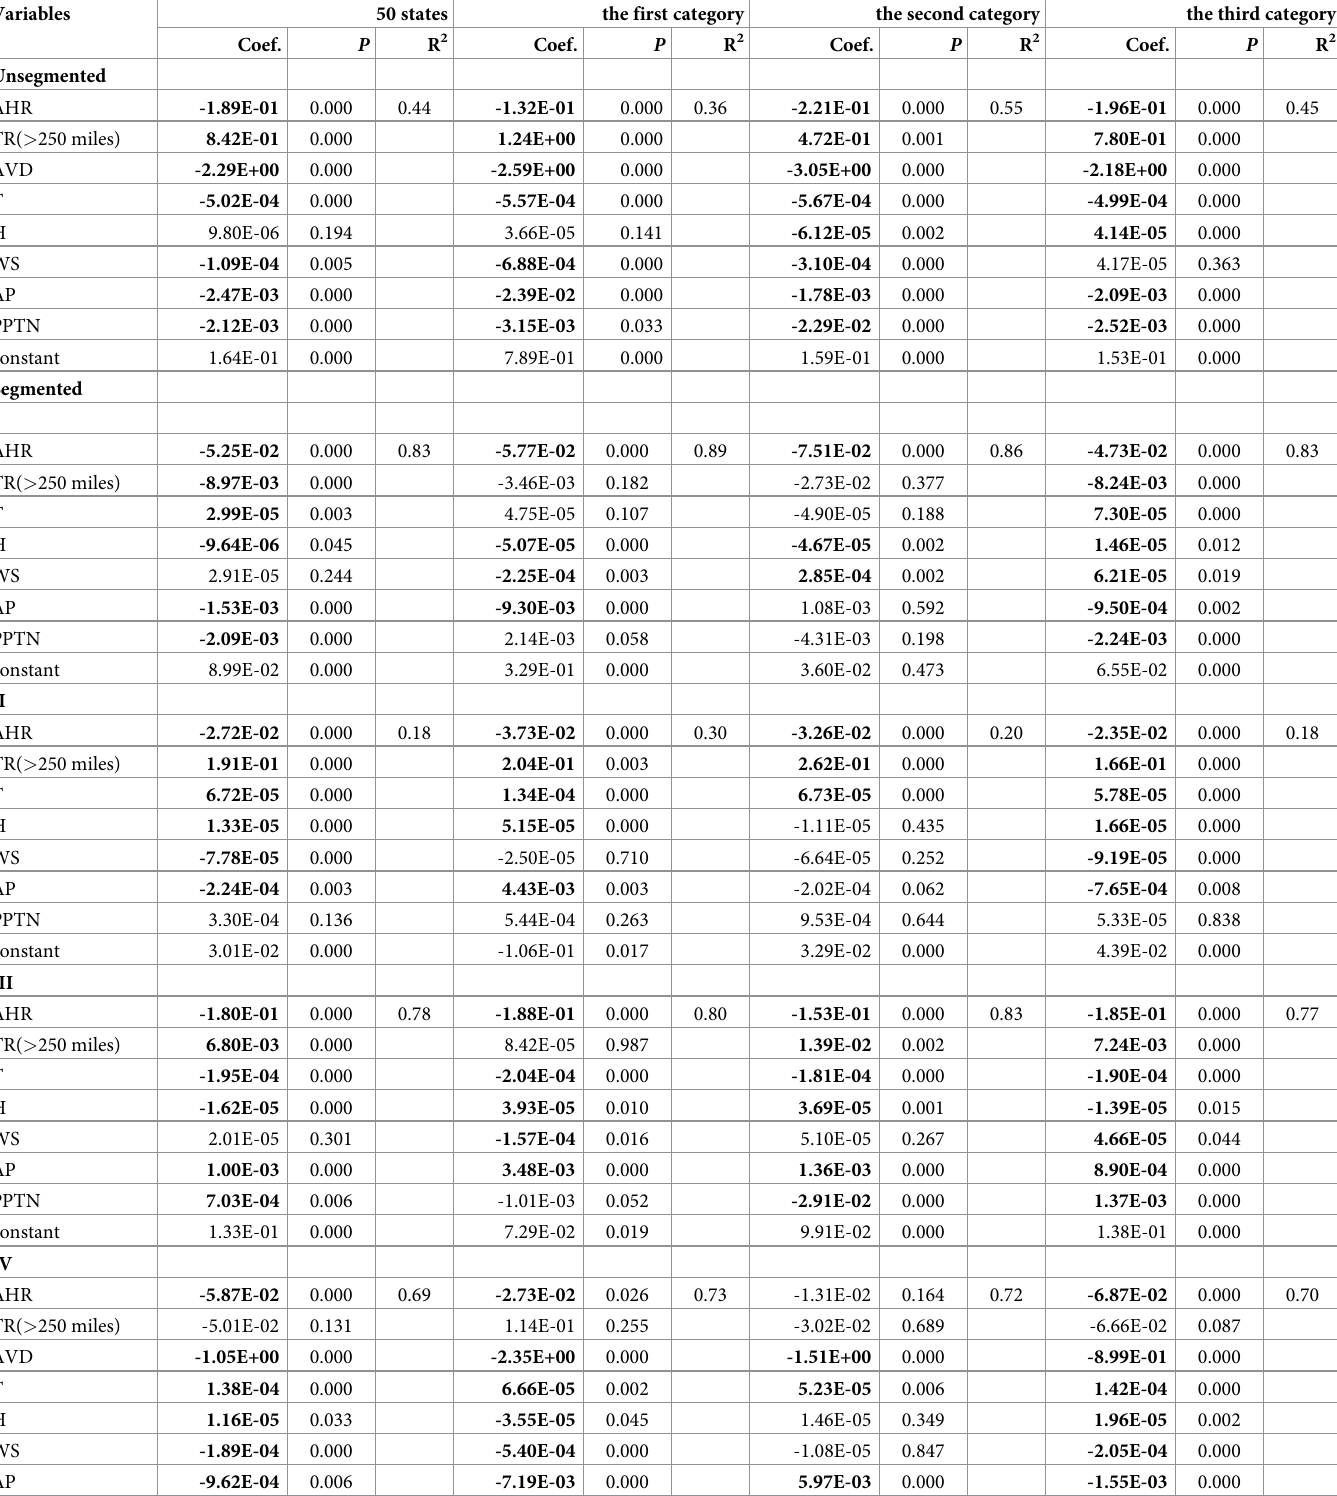
Table 2. Multivariate analysis of influencing factors—DIR postponed for 7 days.